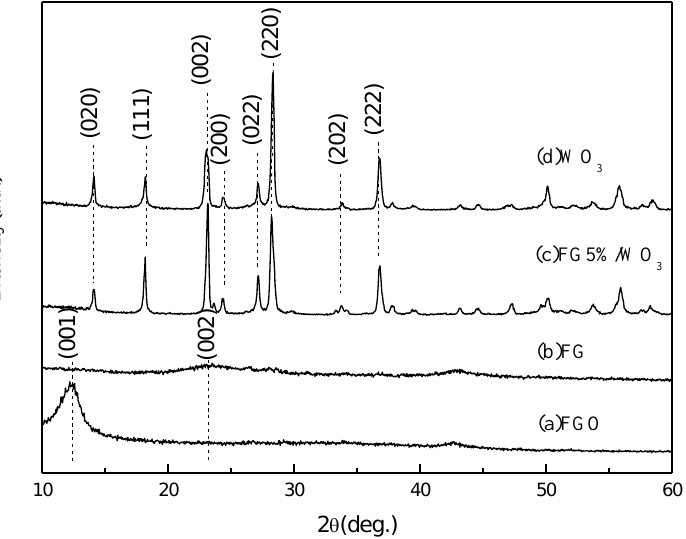
Figure 5. X-ray diffraction patterns of the samples: (a) GO; (b) FG; (c) FG5%/WO nanocomposites and (d) WO 3